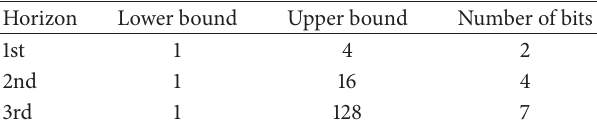
Table 1: The GA’s solution space and